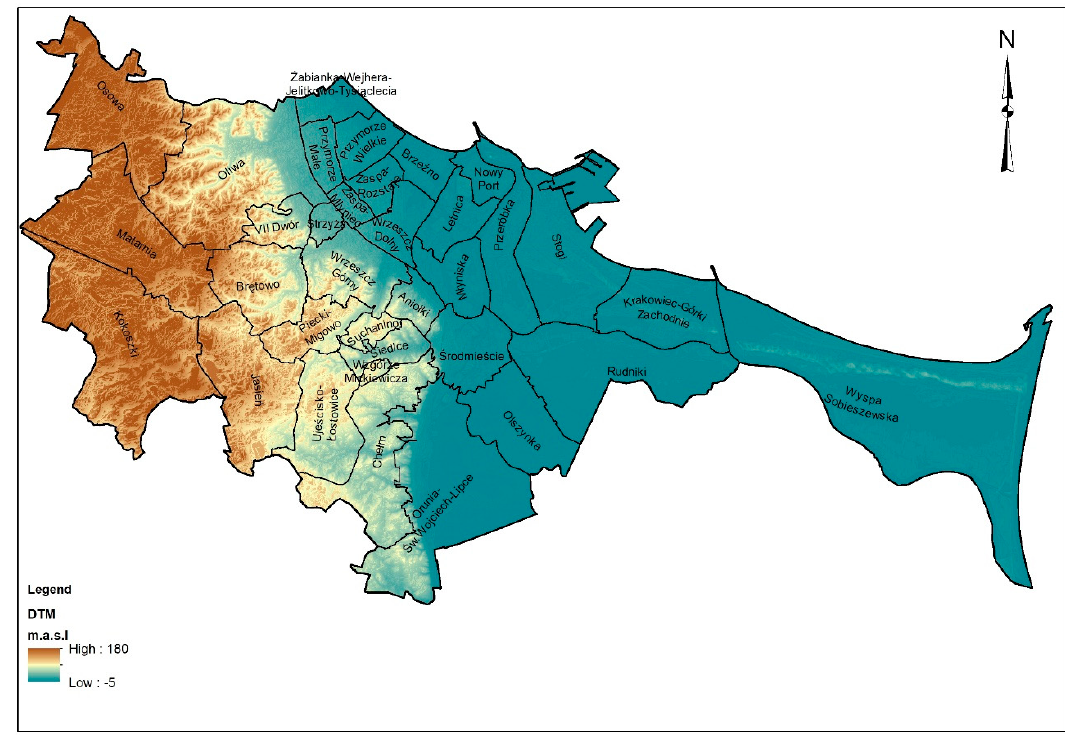
Figure 4. Hypsometric map of Gdansk.